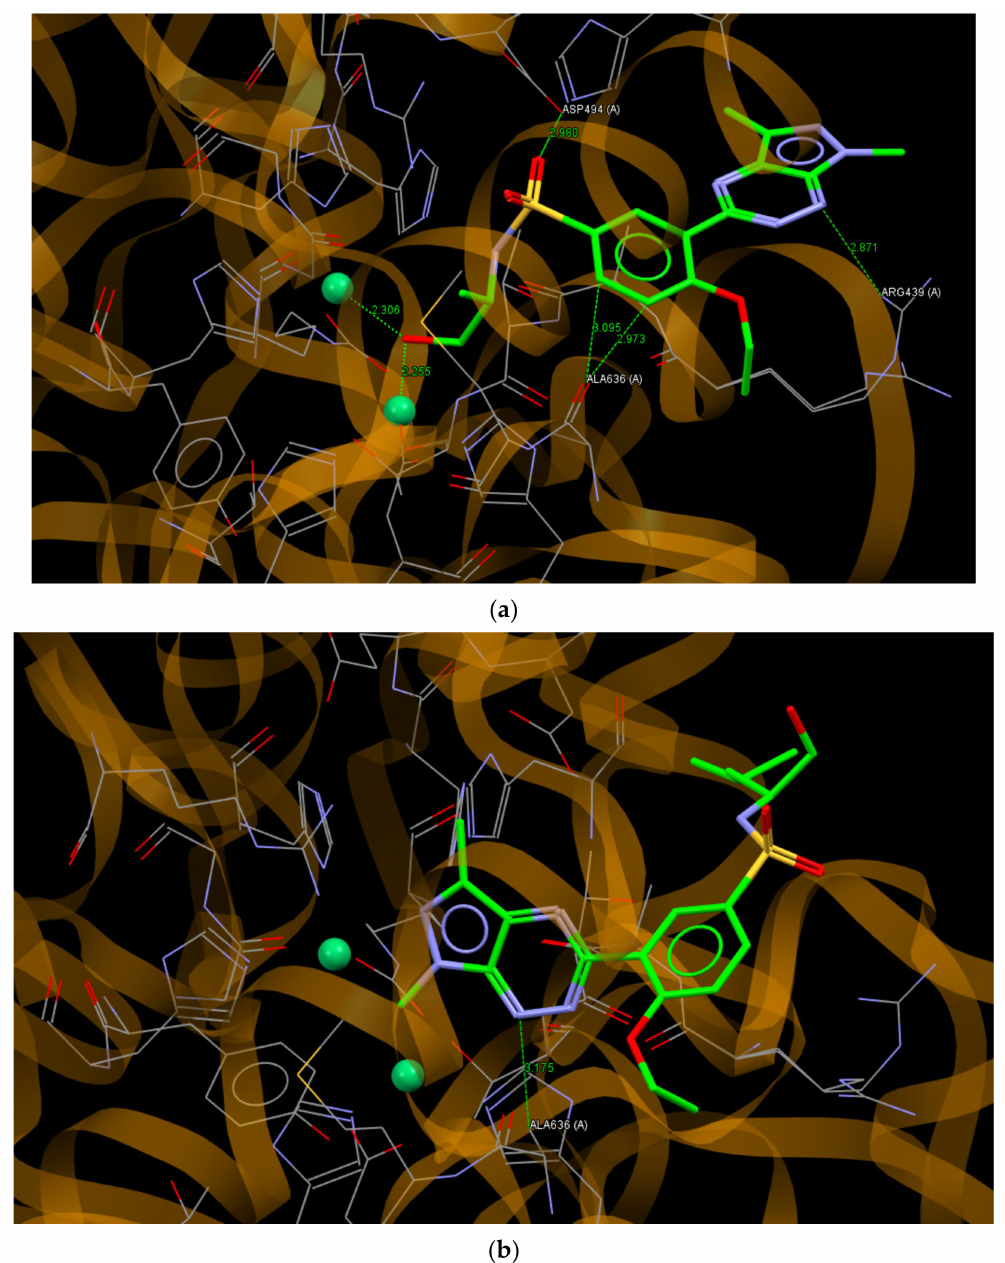
Figure 8. A view of the interaction of ( a ) 8a and ( b ) 8i with amino acids of the binding site in jack bean